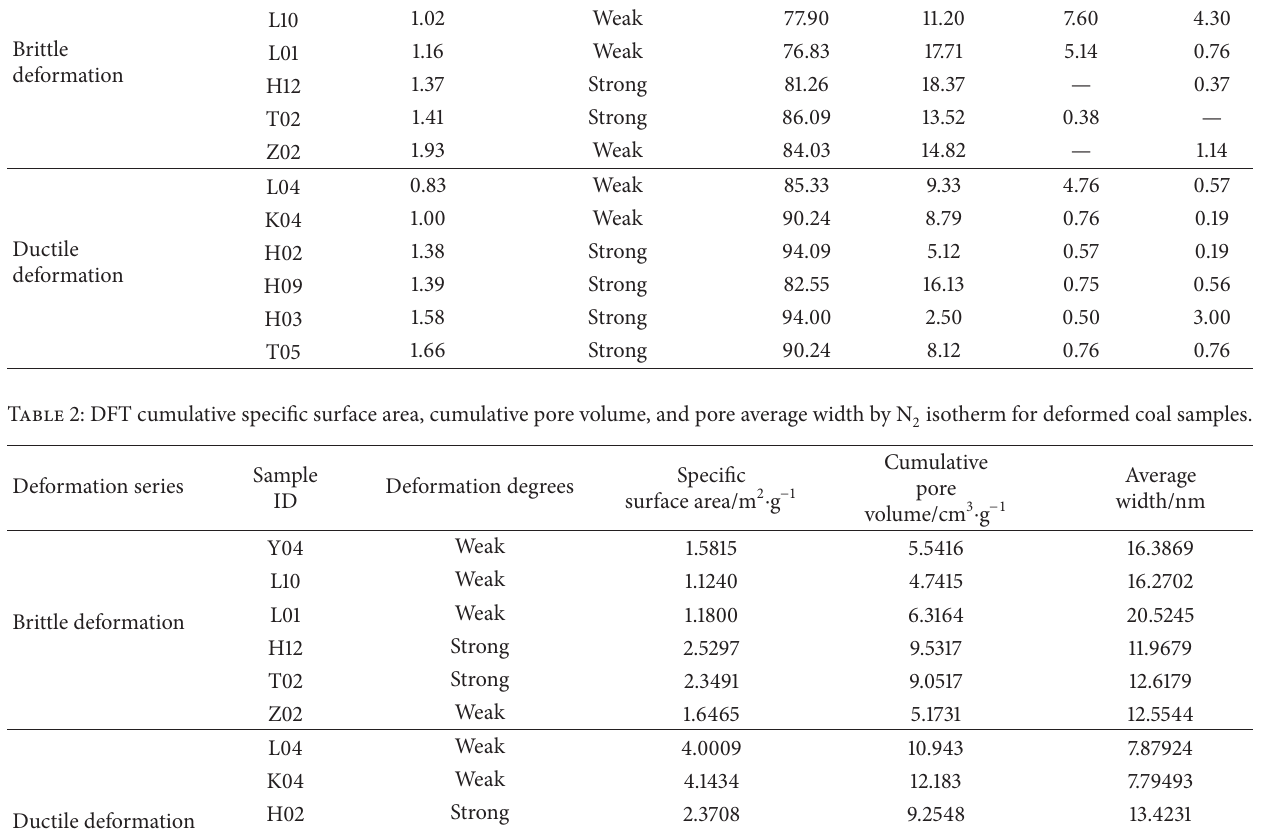
Table 1: Vitrinite reflectance, maceral, and composition of deformed coal samples.